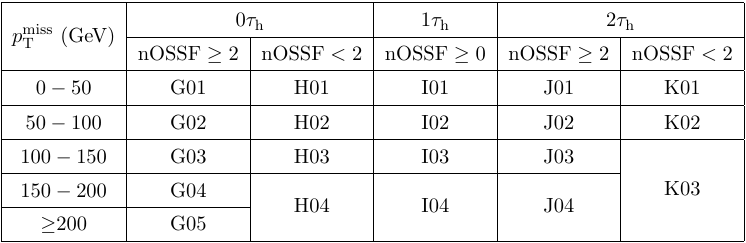
Table 8 . Search region de(cid:12)nition corresponding to categories G{K, events with four or more leptons. Categorization is made based on the number of OSSF pairs (nOSSF). Bin